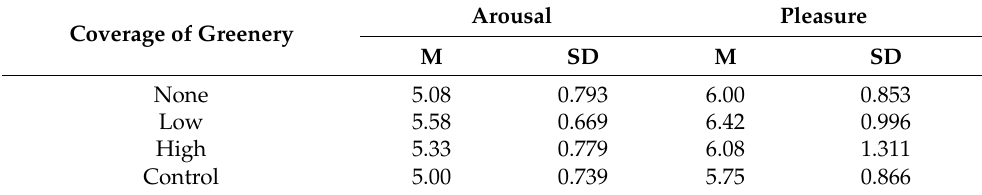
Table 1. Appraisal of the arousal and pleasure evoked by the image stimuli. Coverage of Greenery